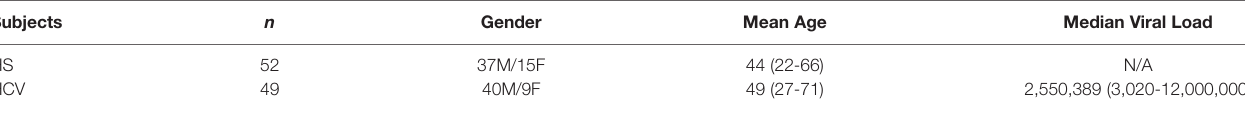
TABLE 1 | Characteristics of the study subjects.